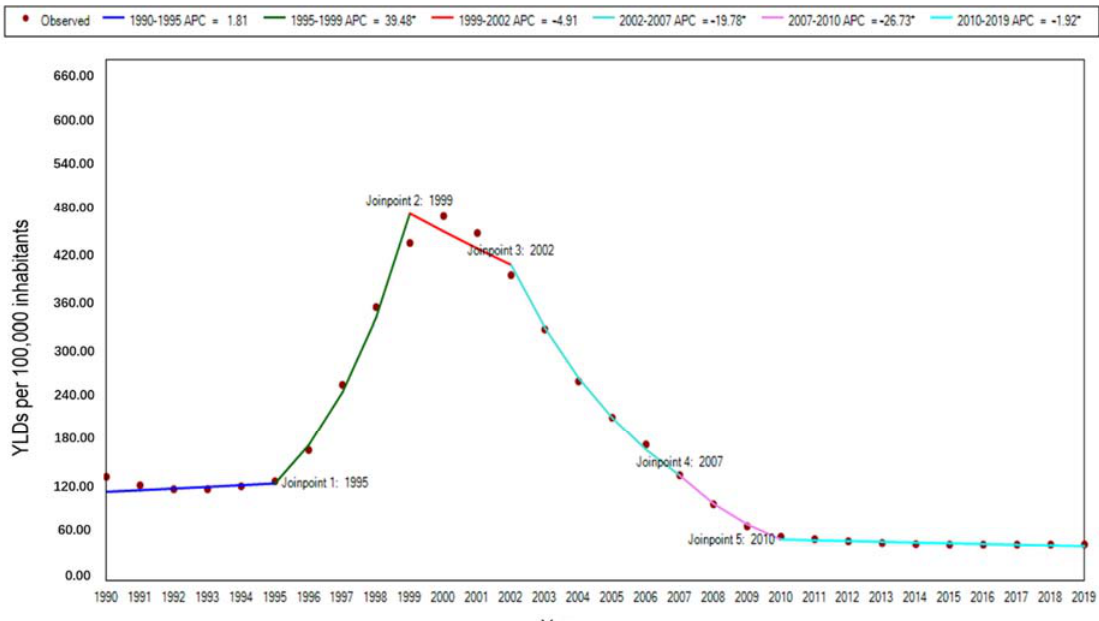
Figure 5. The trend of age-standardized YLD rate for malaria in STP, 1990–2019. Note: * indicates p < 0.05.